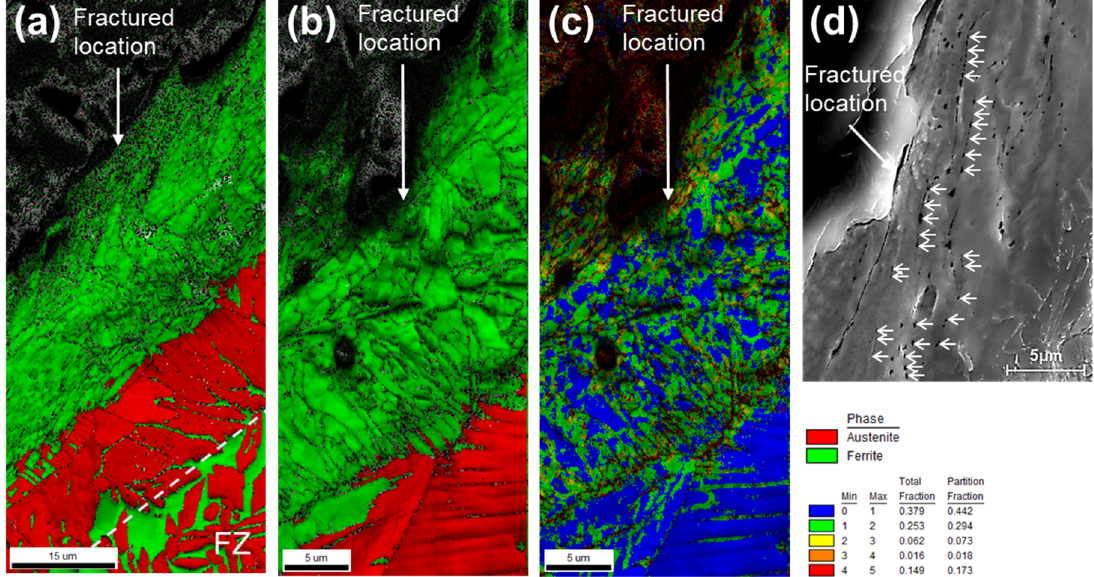
Figure 9. EBSD phase map of ( a ) DF_HC and ( b ) AF_HC. Kernel average misorientation map of ( c ) AF_HC and ( d ) FE-SEM fractograph of DF_HC.